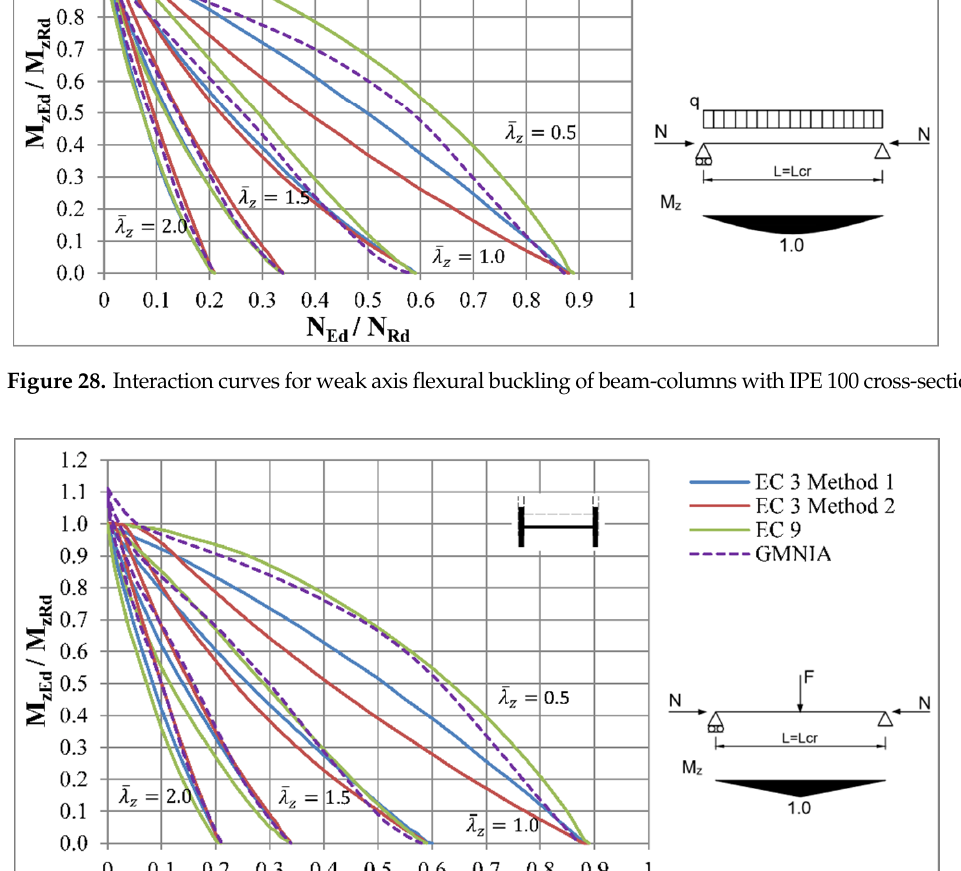
Figure 29. Interaction curves for weak axis flexural buckling of beam-columns with IPE 100 cross-section.